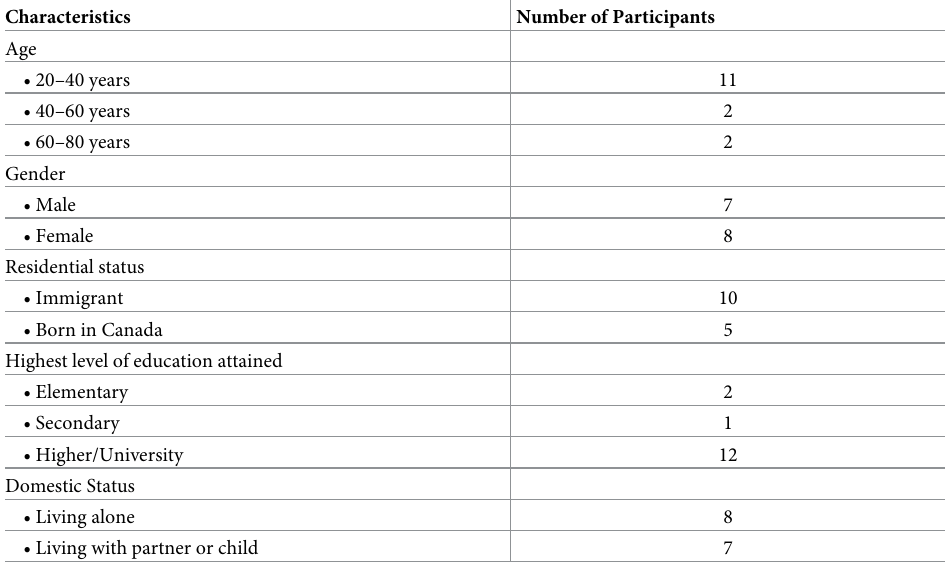
Table 3. Participants’ demographic